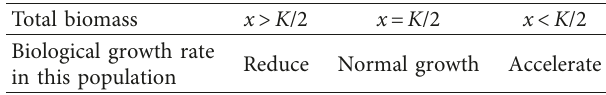
Table 1: Relationship between the total biomass change and growth rate in an area.